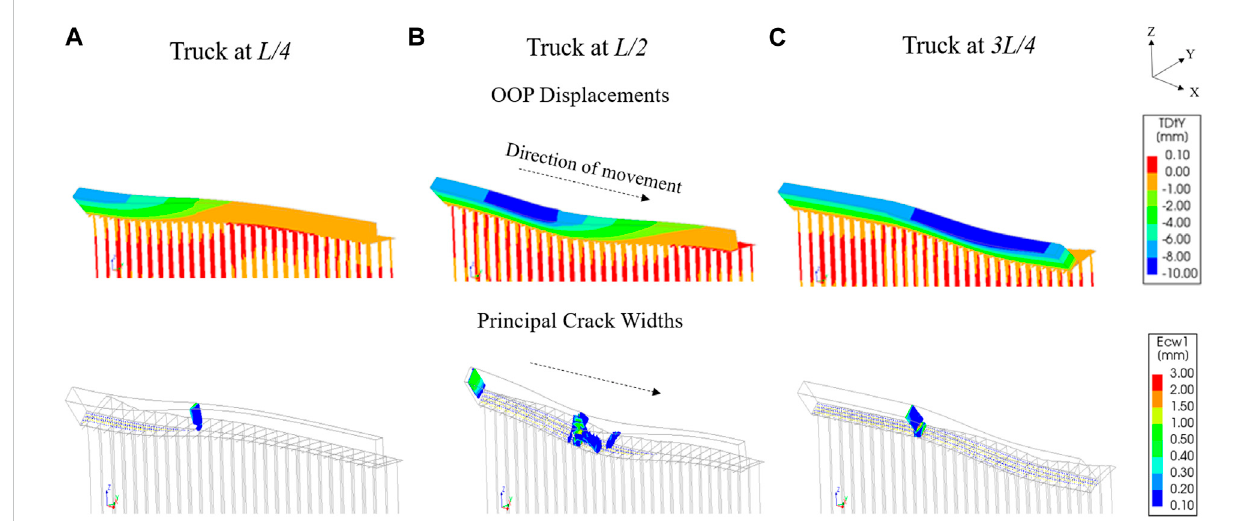
FIGURE 9 Out-of-planedisplacementsandprincipalcrackwidthsof Model1 duringthepassageofthe fi re-truck( LM= 10)atdifferentinstants:truckat (A) L/4 ; (B) L/2 and (C) 3L/4 . (Deformation scale factor = 200).